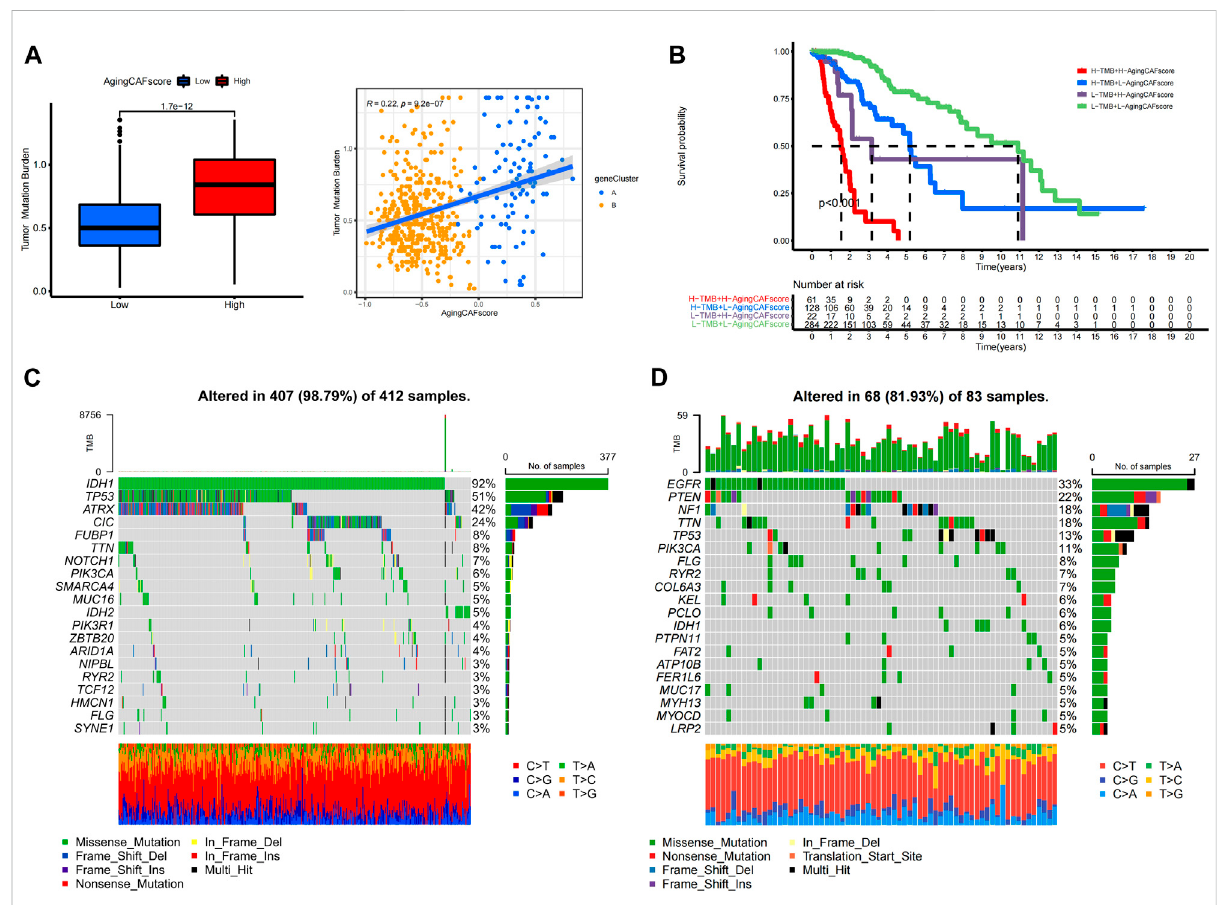
FIGURE 7 Exploration of genetic mutations for samples with low- and high-aging CAF scores. (A) Correlation between the TMB and aging CAF score. (B) Kaplan – MeieranalysisofpatientswithdifferentTMBsandagingCAFscores. (C,D) Top20geneswiththehighestmutationfrequenciesinthelow- (C) and high- (D) aging CAF score groups. CAF, cancer-associated fi broblast; TMB, tumor mutation